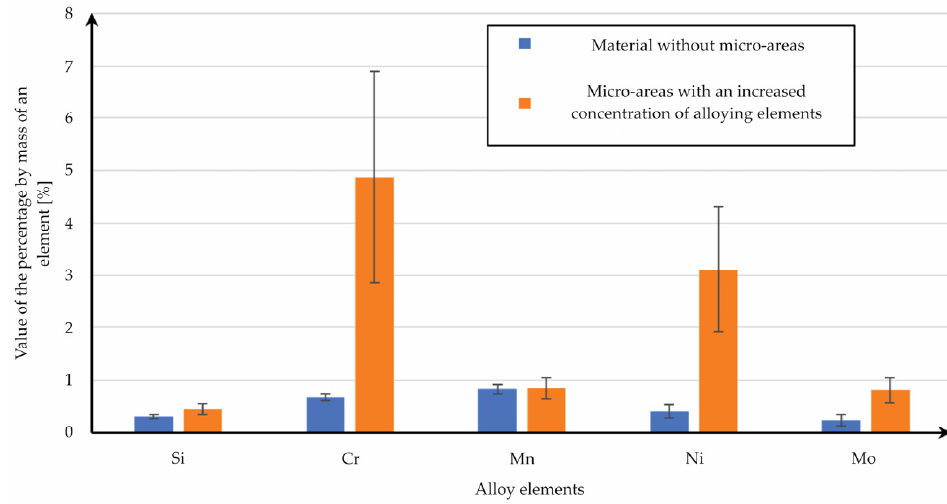
Figure 7. A bar chart of the exact alloy element percentages in the heterogeneous micro-area.